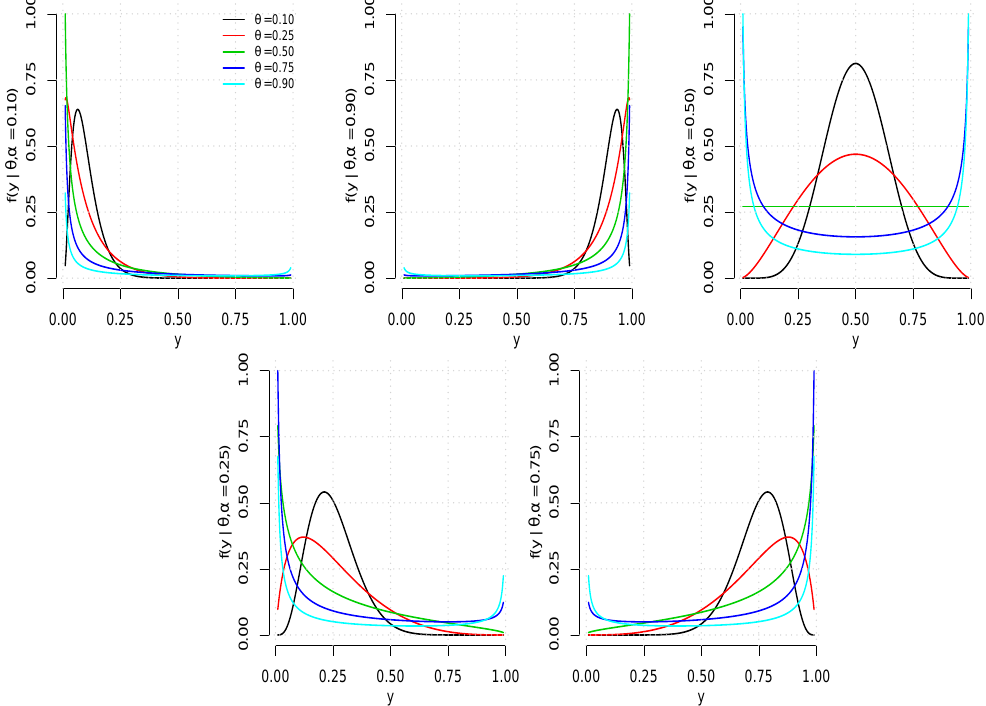
Figure 1. Plots of the PDF stated in (1) for different combinations of θ and α